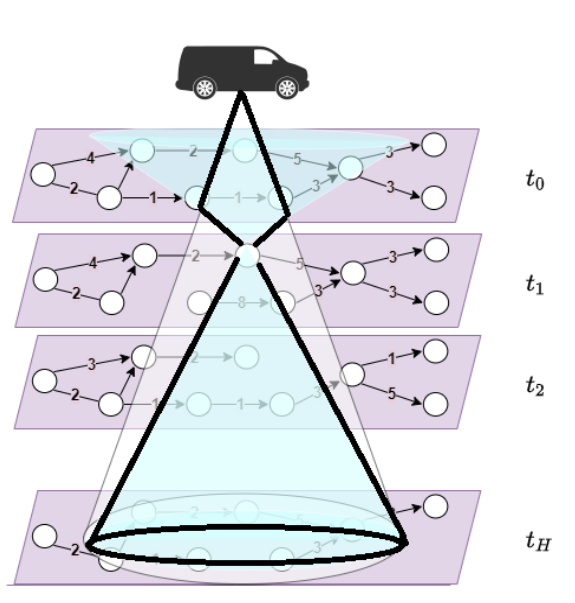
Figure 6. Action zone after insertion of a